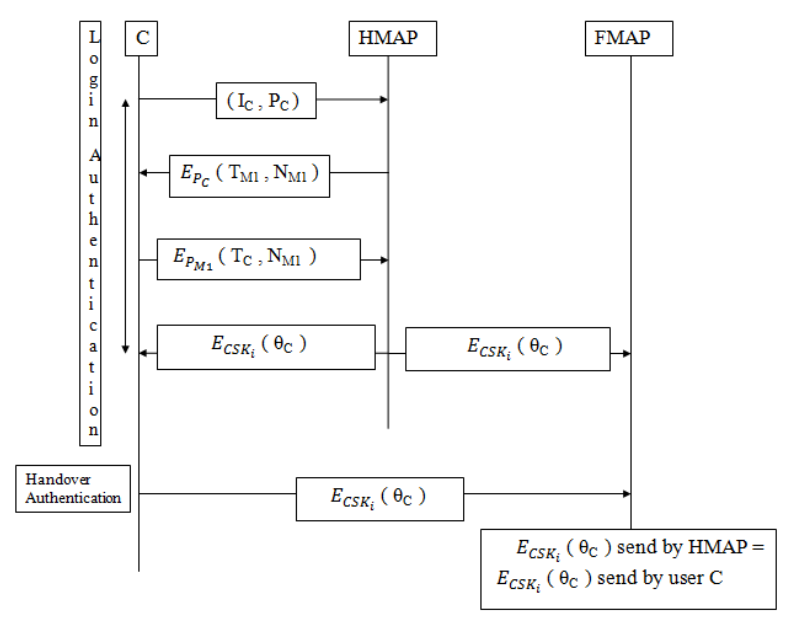
Figure 4. Proposed protocol during LAP and HAP.